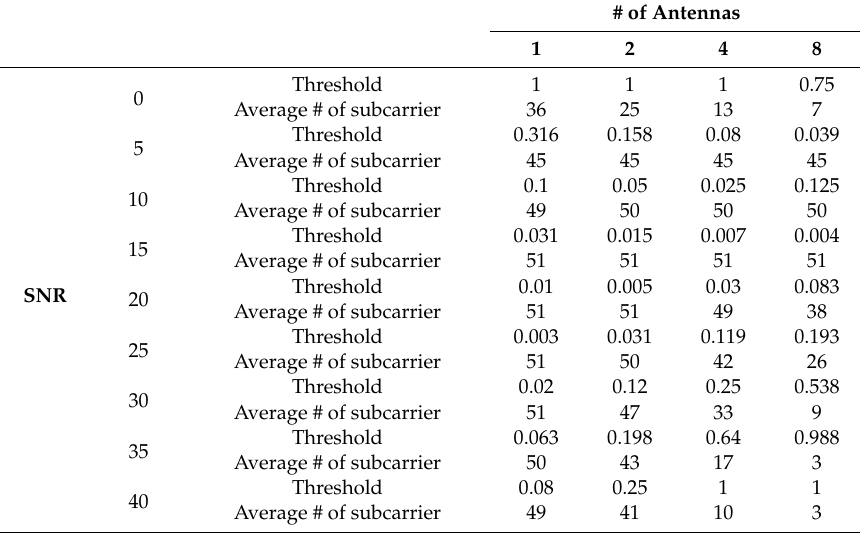
Figure 8. Flowchart for searching the optimal thresholds (TCST (tag’s channel state-based threshold) method). Table 1. Data used in Euclidean distance calculation and optimal threshold for each SNR (signal to noise ratio) and number of antennas (SET